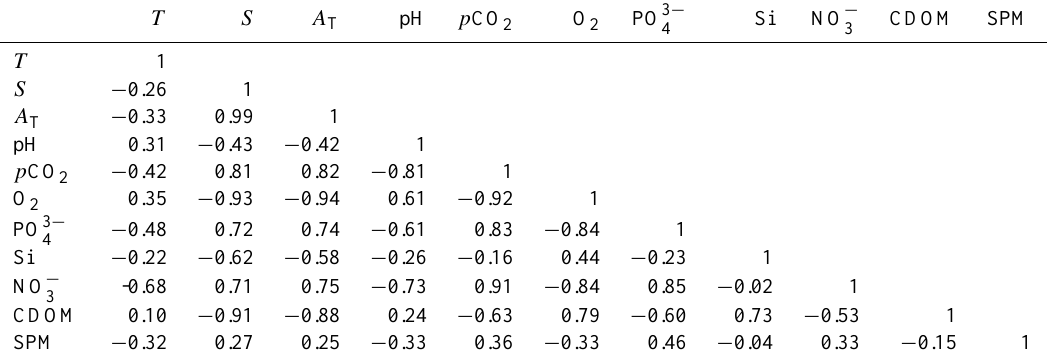
Table 3. Correlation matrix of the environmental parameters observed in the Buor-Khaya Bay in September 2011 ( n =